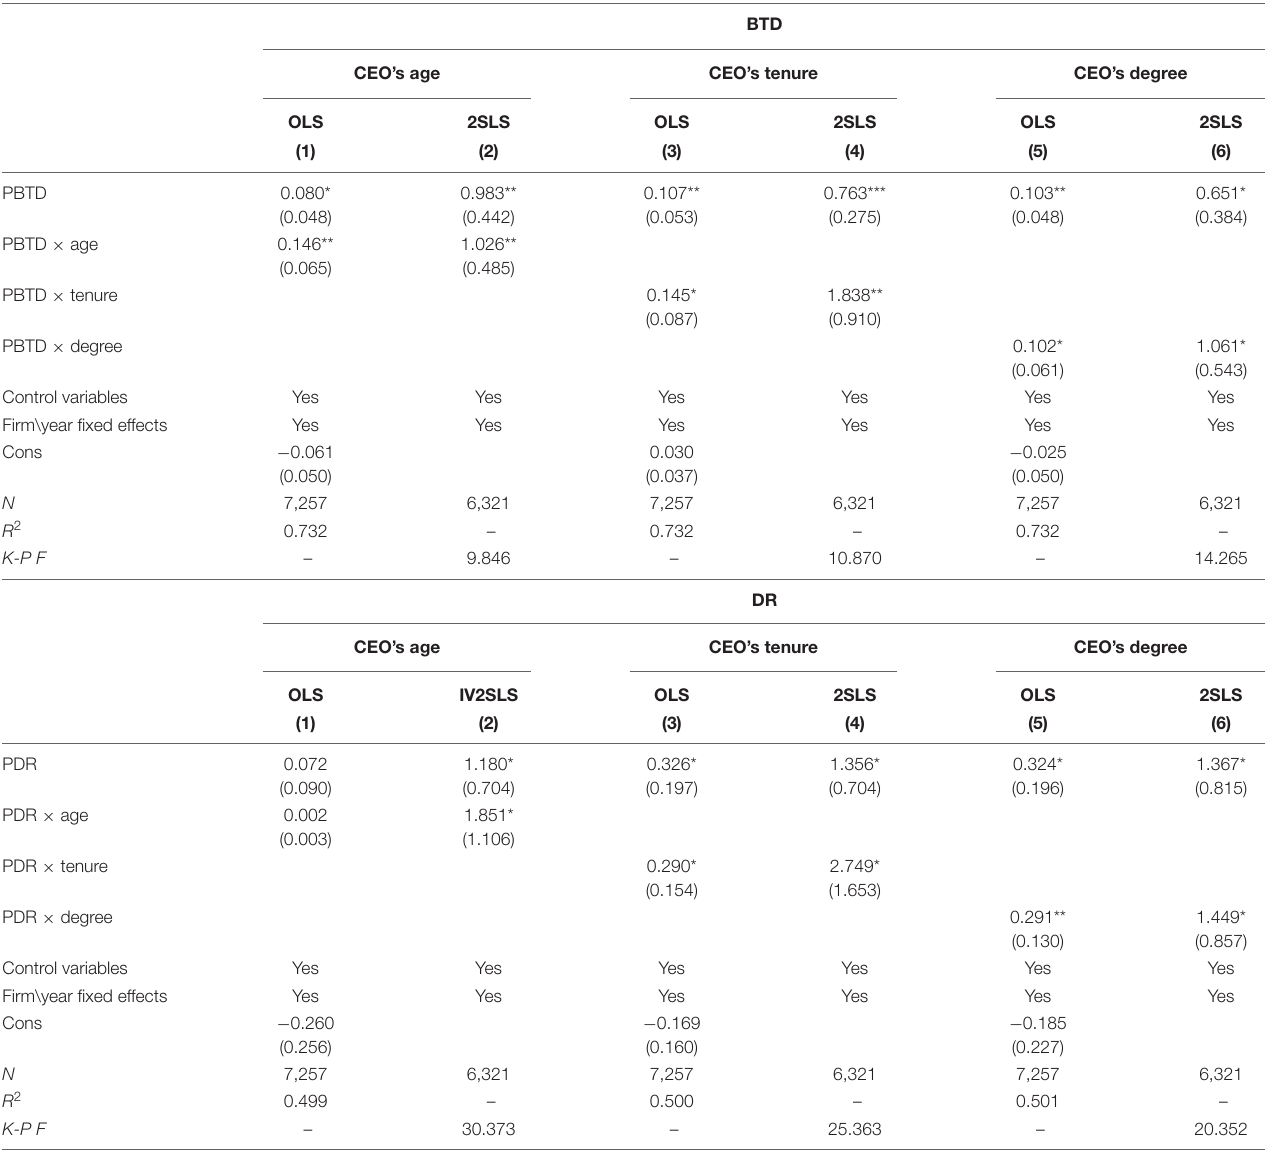
TABLE 4 | Managers’ reputation